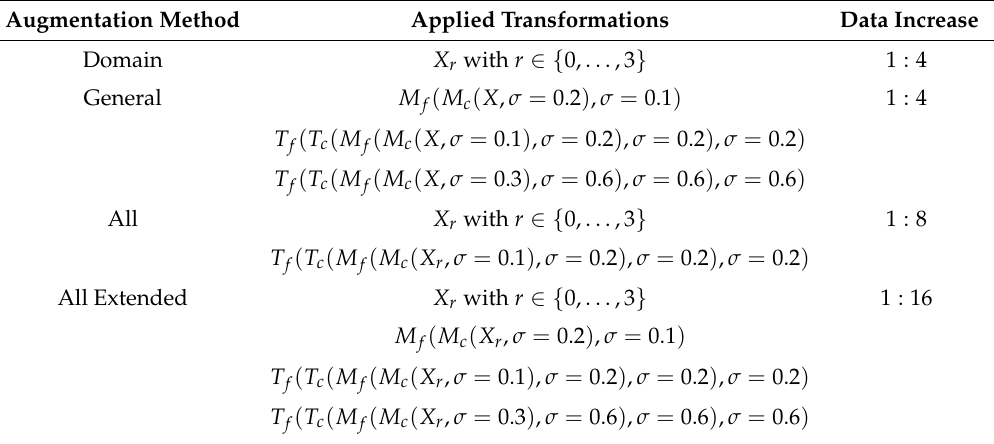
Table 2. The tested data augmentation methods for which the evaluation will be carried out. r ∈ { 0, . . . ,3 } denotes the original orientation and the three flips. M magnitude and time